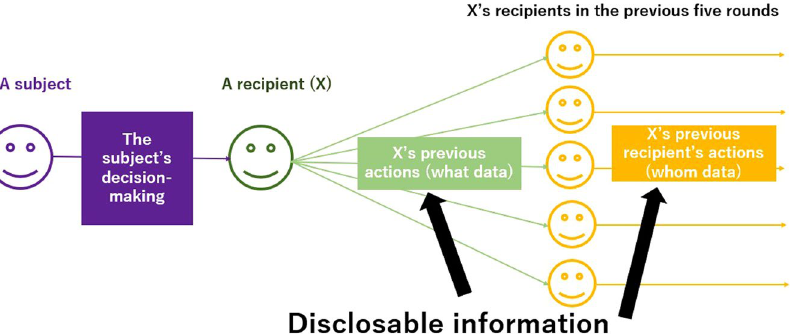
Figure 1. Disclosable information subjects can receive. This illustration shows the information disclosed to subjects in an ‘indirect helping game’ before they decide on their actions (cooperation or defection) in each round. Every subject meets a recipient, called X, who is assigned by the system in each round. The information about X falls into two categories. First, X’s actions (what data) in the previous five rounds are disclosable. For example, if what data (X’s previous action) in the third-last round is disclosed, either ‘C’ (cooperation) or ‘D’ (defection) is shown. Second, X’s recipients’ actions (whom data) in the previous five rounds are also disclosable. For example, if whom data (about X’s recipient) in the third-last round is disclosed, an integer between 0 and 5 is shown. The integer represents how many times X’s recipient cooperated in the five rounds preceding that round (the number of ‘C’ values), in this case, the five rounds from the fourth-last round to the eighth-last round. Therefore, the total number of pieces of disclosable information about X is ten (five items of what data and five items of whom